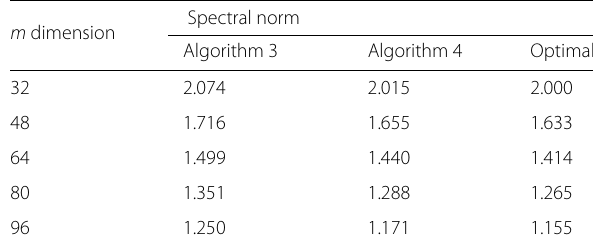
Table 1 Spectral norm of m × N frames with m = 32 : 16 : 96 and N = 128 obtained with Algorithm 3 and Algorithm 4 Spectral norm m dimension Algorithm 3 Algorithm 4 Optimal